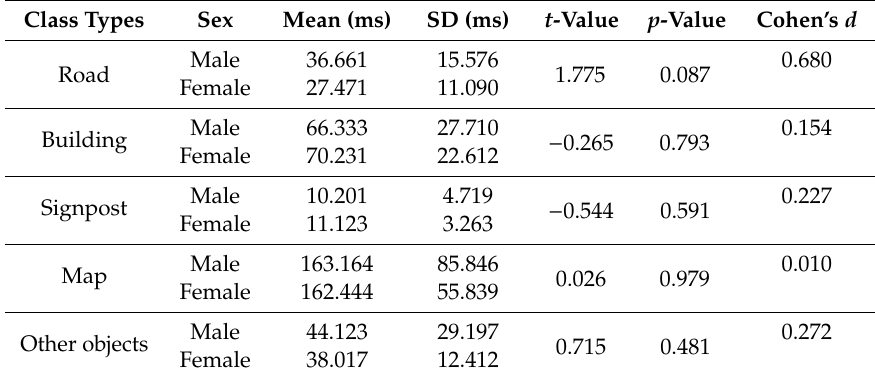
Table 4. Fixation durations of males and